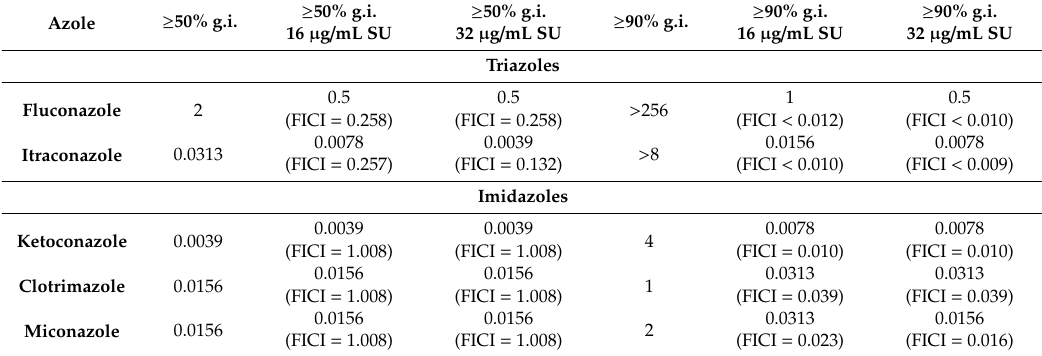
Table 1. Concentrations ( µ g / mL) of triazoles (fluconazole and itraconazle) or imidazoles (ketoconazole, clotrimazol, miconazole) leading to either ≥ 50 or ≥ 90% growth inhibition (g.i.) of C. albicans CAF2-1 strain. These values were given alone or in combination with surfactin (SU) ( µ g / mL) towards C. albicans CAF2-1 strain. Fractional inhibitory concentration indexes (FICIs) were included in bracelets. ≥ 50% g.i. ≥ 50% g.i. ≥ ≥ 90% g.i. ≥ 90% g.i. 90% g.i. Azole ≥ 50% g.i. 16 µ g / mL SU 32 µ g / mL SU 16 µ g / mL SU 32 µ g / mL